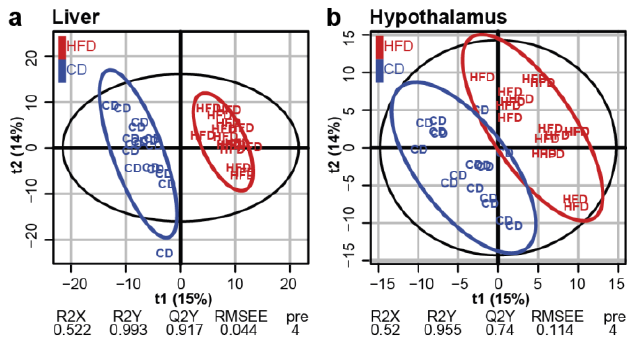
Figure 3. Post-weaning HFD had a global impact on the liver and hypothalamus metabolomes. Score plots from the PLS-DA classification into HFD and CD groups for the LI ( a ) and HYP ( b ). No model was built for WOB. A model is considered robust when the response variance explained (R2Y) is higher than the predictive performance of the model (Q2Y). A model with a Q2Y > 0.5 is considered to have a good predictive performance.